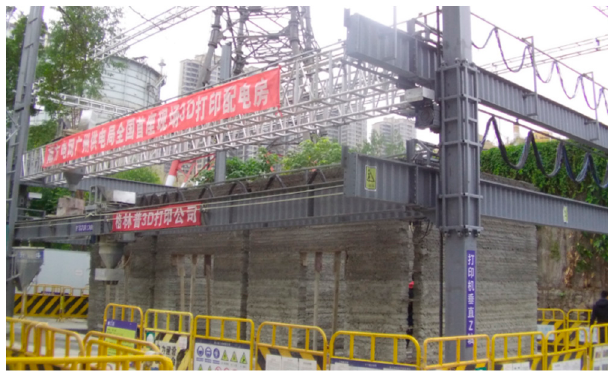
Figure 7. Overview of the 3D printer.